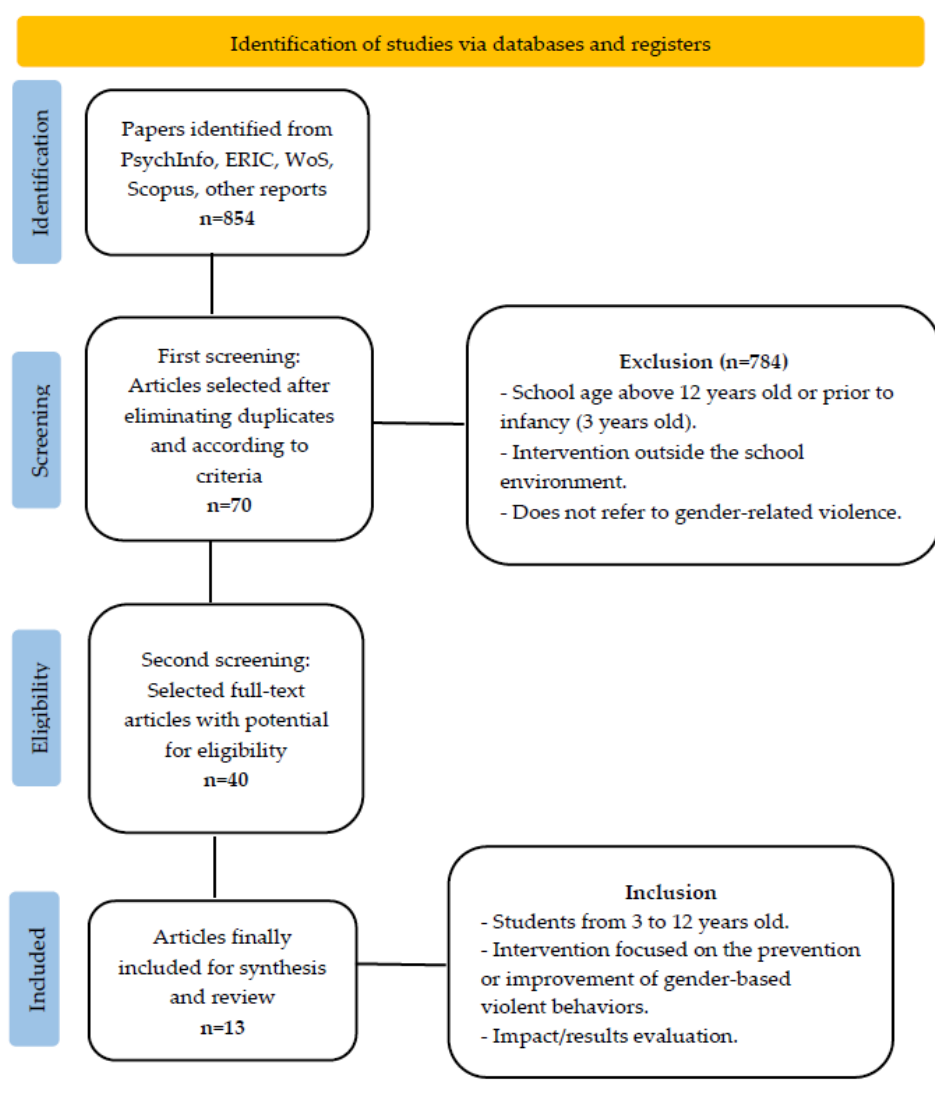
Figure 1. PRISMA Figure 1. PRISMA flowchart.